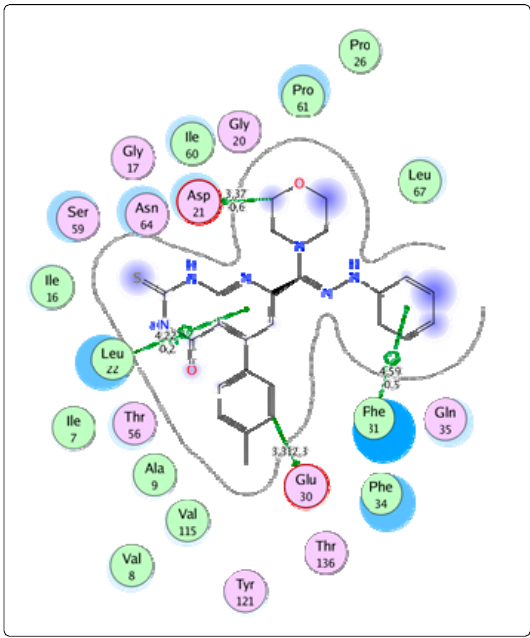
Figure 2. Hhydrogen bonding between the compound 7b and the DHFR enzyme pocket amino acids.